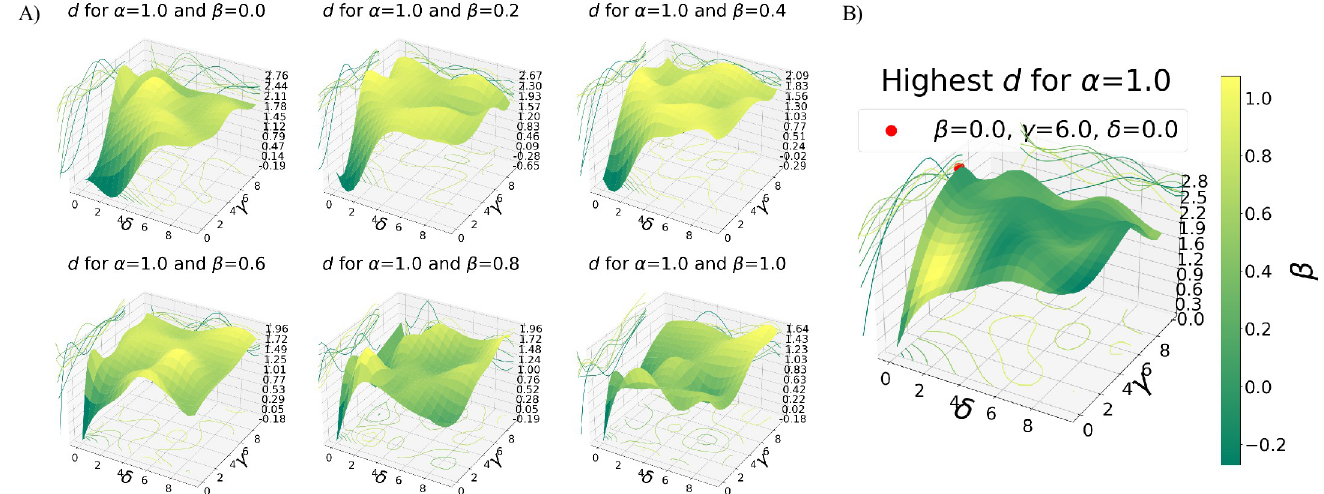
Fig 4. Selection of the absolute best sampling parameters. A) d as a function of varying values of γ and δ . Each plot is obtained with a fixed value for β , and for all the plots the same fixed value of α = 1.0 is used. The colouring is given by the d value. The plotted surfaces are obtained with an interpolation of the effectively computed values, that were obtained with all the possible combination, for each β value, of γ = [0, 2, 4, 6, 8, 10] and δ = [0, 2, 4, 6, 8, 10]. B) For each plot on the left, the point corresponding to the highest d is selected. The colouring is given by the β value (as described by the color-bar). The plotted surface is obtained from the interpolation of these points, and shows, for all the δ - γ combinations the value of β that will result in the best sampling. The maximum of this surface (red points) corresponds to the best sampling parameters.